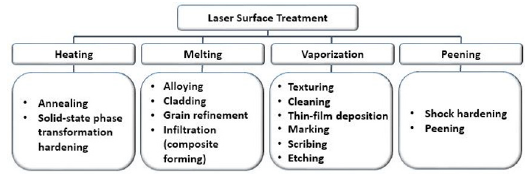
Figure 1. Laser surface treatments 1 .